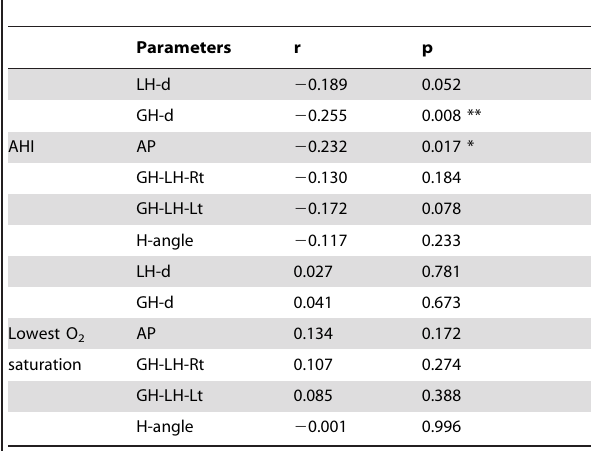
Table 2. Correlation of AHI and lowest O2 saturation with hyoid bone